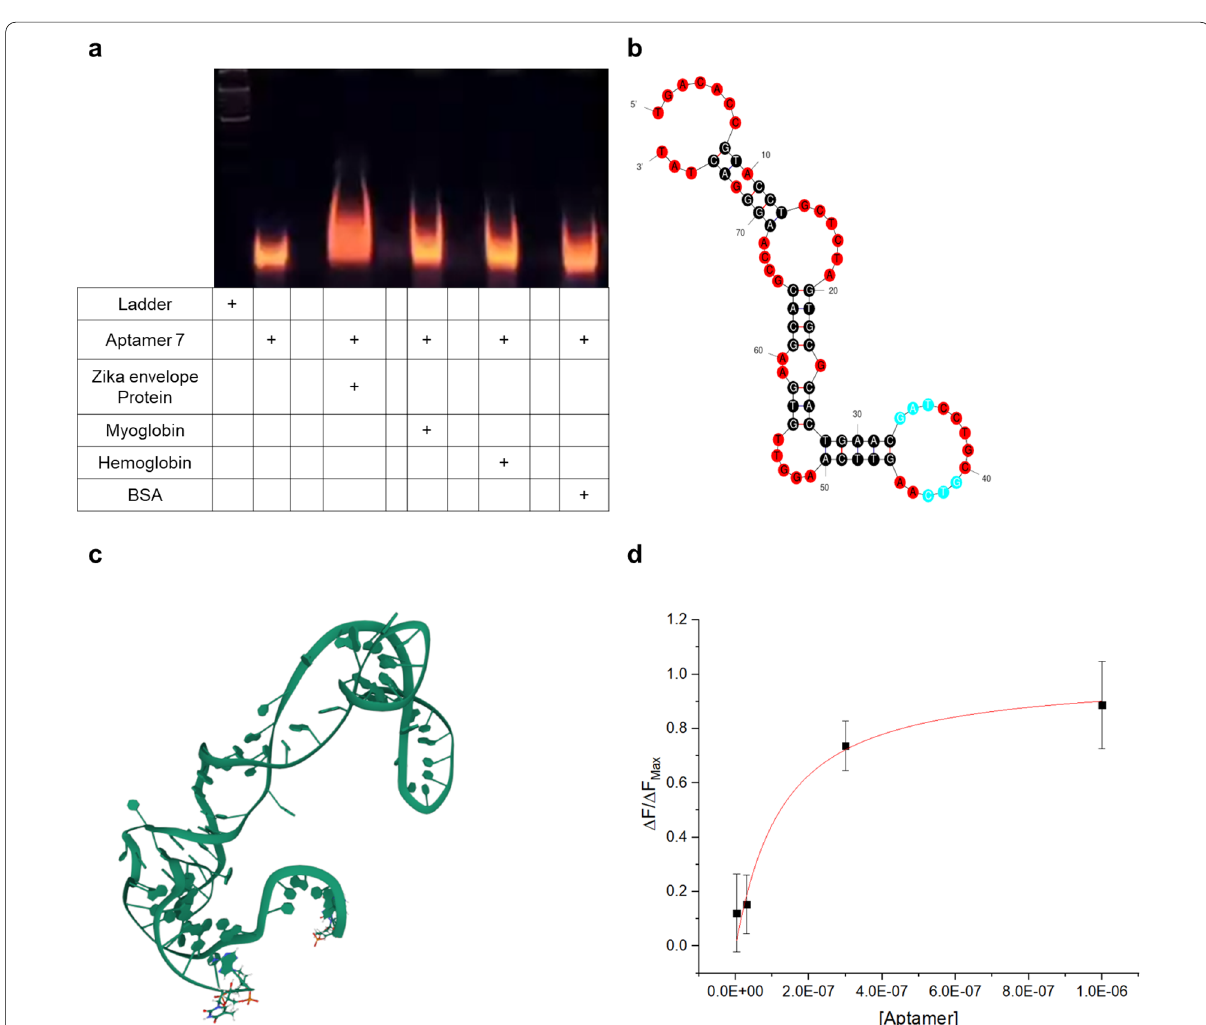
Fig. 2 a 8% TBE-PAGE result of Zika Aptamer; b Expected 2D structure of Zika aptamer base; c Expected 3D structure of Zika aptamer base; d Binding affinity of Zika